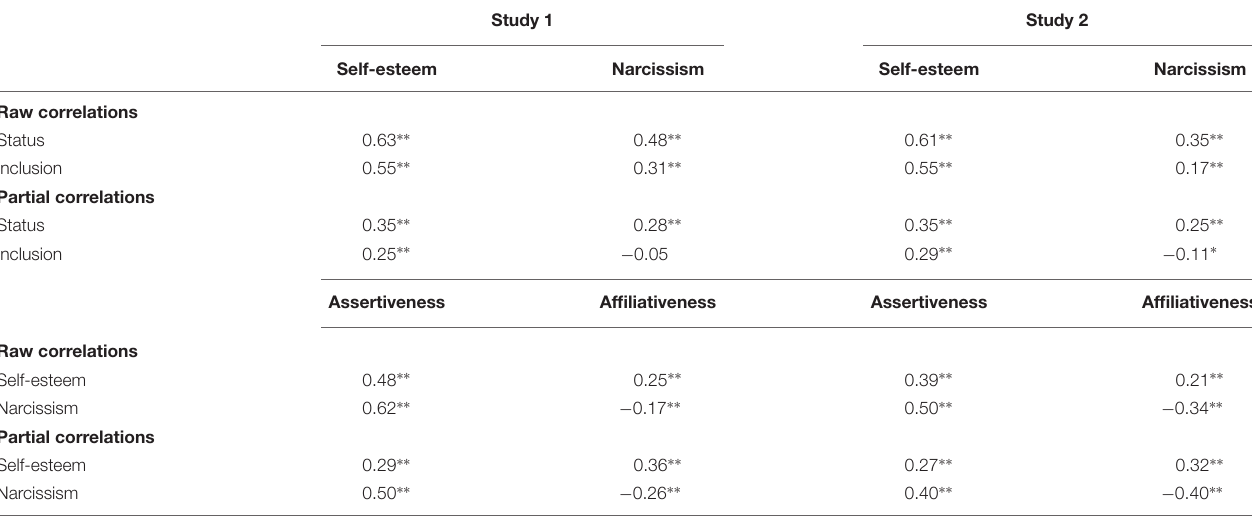
TABLE 3 | Raw and partial correlations between social relations, self-regard, and interpersonal